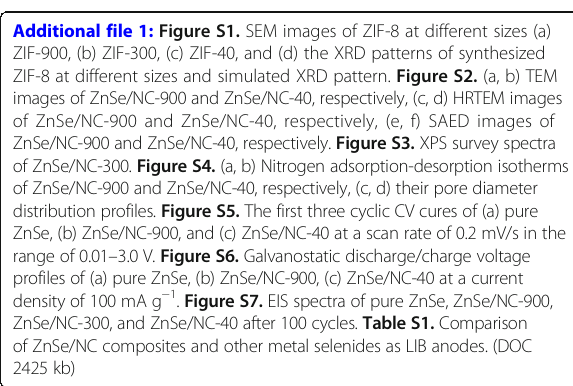
Additional file 1: Figure S1. SEM images of ZIF-8 at different sizes (a) ZIF-900, (b) ZIF-300, (c) ZIF-40, and (d) the XRD patterns of synthesized ZIF-8 at different sizes and simulated XRD pattern. Figure S2. (a, b) TEM images of ZnSe/NC-900 and ZnSe/NC-40, respectively, (c, d) HRTEM images of ZnSe/NC-900 and ZnSe/NC-40, respectively, (e, f) SAED images of ZnSe/NC-900 and ZnSe/NC-40, respectively. Figure S3. XPS survey spectra of ZnSe/NC-300. Figure S4. (a, b) Nitrogen adsorption-desorption isotherms of ZnSe/NC-900 and ZnSe/NC-40, respectively, (c, d) their pore diameter distribution profiles. Figure S5. The first three cyclic CV cures of (a) pure ZnSe, (b) ZnSe/NC-900, and (c) ZnSe/NC-40 at a scan rate of 0.2 mV/s in the range of 0.01 – 3.0 V. Figure S6. Galvanostatic discharge/charge voltage profiles of (a) pure ZnSe, (b) ZnSe/NC-900, (c) ZnSe/NC-40 at a current density of 100 mA g − 1 . Figure S7. EIS spectra of pure ZnSe, ZnSe/NC-900, ZnSe/NC-300, and ZnSe/NC-40 after 100 cycles. Table S1. Comparison of ZnSe/NC composites and other metal selenides as LIB anodes. (DOC 2425